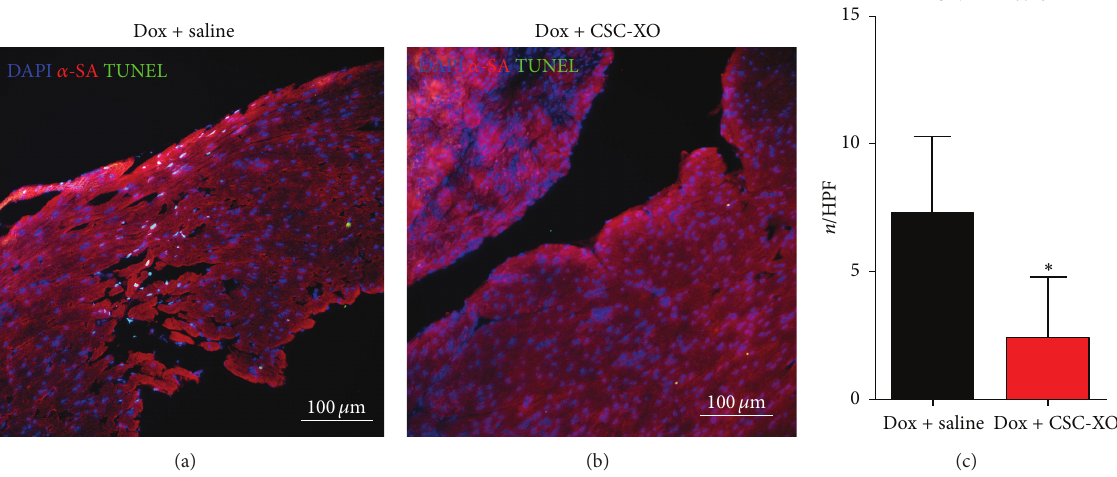
Figure 5: Comparison of TUNEL staining of specimens receiving saline (a) or CSC-XO (b). Counting total amount of TUNEL Pos cells in each field of view indicates a significant drop in apoptotic cells